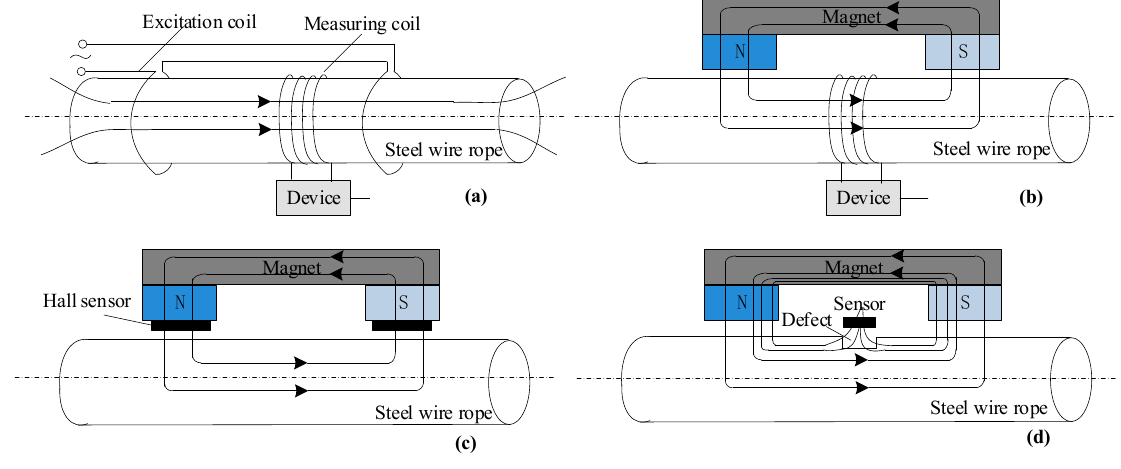
Figure 2. Electromagnetic non-destructive detection principle of steel wire rope. ( a ) Main magnetic flux detection method based on coil excitation; ( b ) main magnetic flux detection method based on permanent magnet excitation; ( c ) return magnetic flux detection method based on permanent magnet excitation; and ( d ) leakage magnetic flux detection method based on permanent magnet excitation.